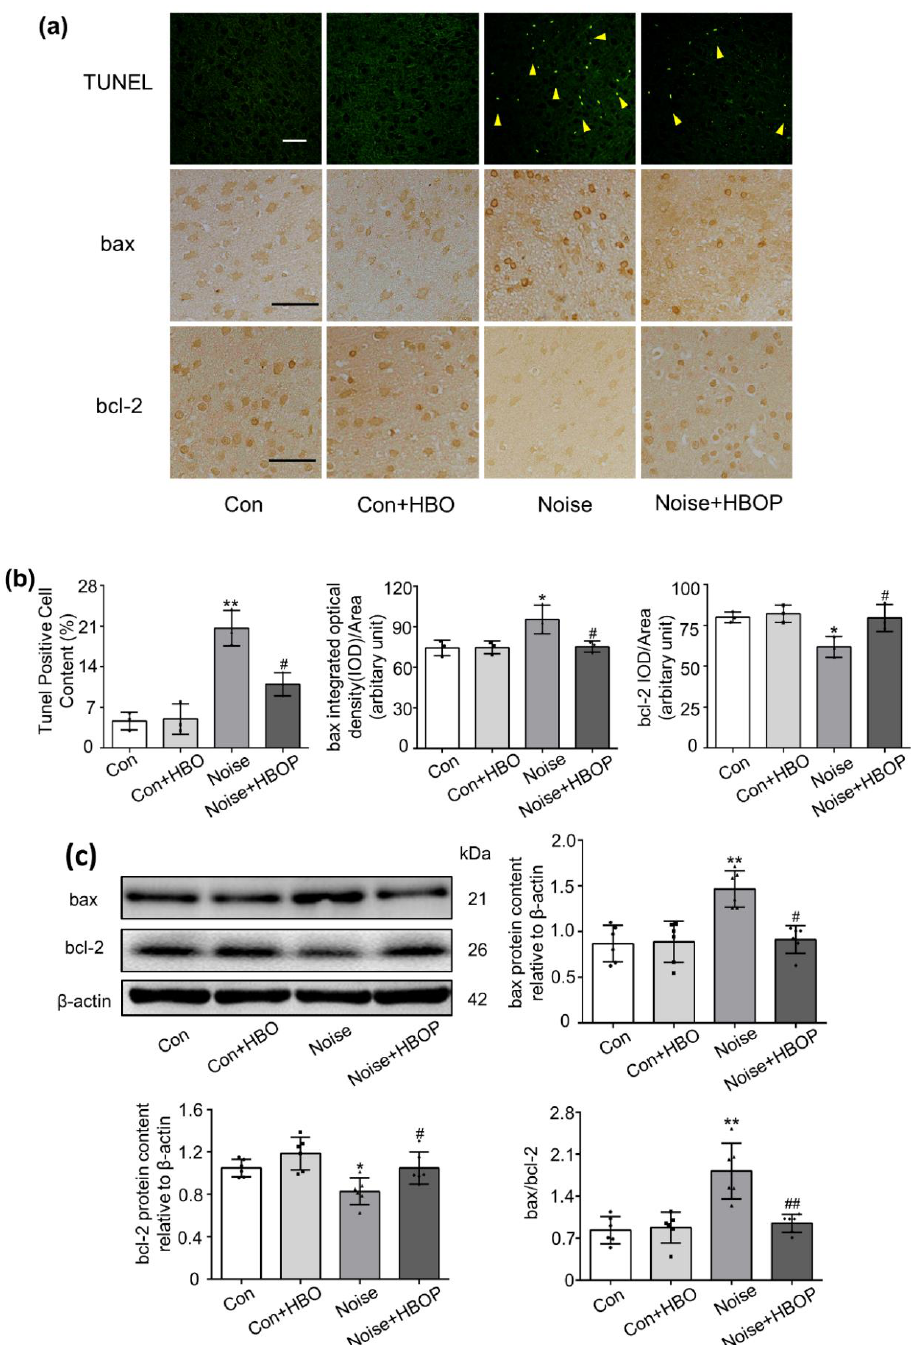
Figure 2. Original images ( a , c ) and summarized data ( b , c ) showing neuronal apoptosis, protein expression of B cell lymphoma-2 (bcl-2) and bcl-2 associated X protein (bax) in auditory cortex (AC) of mice in Con or Noise group with or without hyperbaric oxygen treatment detected by TdT-mediated dUTP nick-end labeling (TUNEL) ( a ), immunohistochemistry staining (IHC) ( a ) or western blotting ( c ) assay. The arrows indicate apoptotic neurons, in TUNEL, magnification ×200, in IHC, magnification ×400, scale bar = 50 μm. Data are shown as means ± SD, n = 3 in IHC or TUNEL, n = 6 in western blot assay, ** P < 0.01, * P < 0.05 vs. Con, ## P < 0.01, # P < 0.05 vs. Noise. All individual data points were shown in the figure using di ff erent shapes, • for Con group, (cid:4) for Con + HBO group, (cid:78) for Noise group, (cid:95) for Noise + HBOP